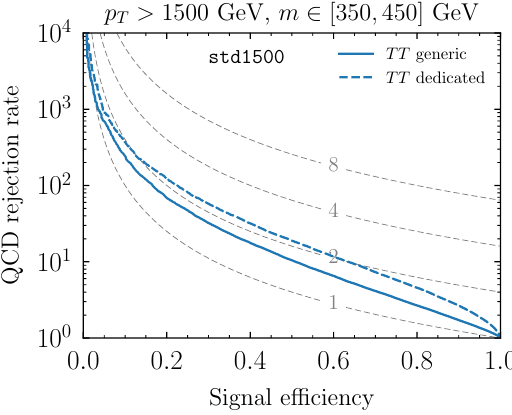
Figure 16 . Signal e(cid:14)ciency versus QCD rejection for jets resulting from decays of 400 GeV vector- like quarks T , decaying as T cc (cid:22) c . Solid: generic std1500 tagger; dashed: dedicated tagger. ! that the generic tagger has a moderate performance for this signal, with approximately 10% QCD e(cid:14)ciency at 50% signal e(cid:14)ciency. One might wonder if the sensitivity to such signals is lost by training the generic tagger only on colour-singlet jets. However, the ded- icated tagger has only marginally better performance, which suggests that the reason for the moderate performance of the generic tagger is that this type of signal is intrinsically hard to distinguish from QCD